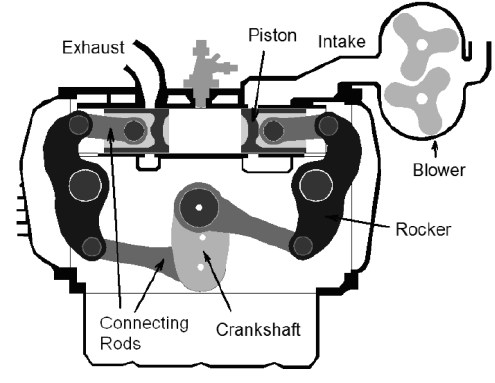
Fig. 1. Kinematic linkage in the rocker Commer engine [1,